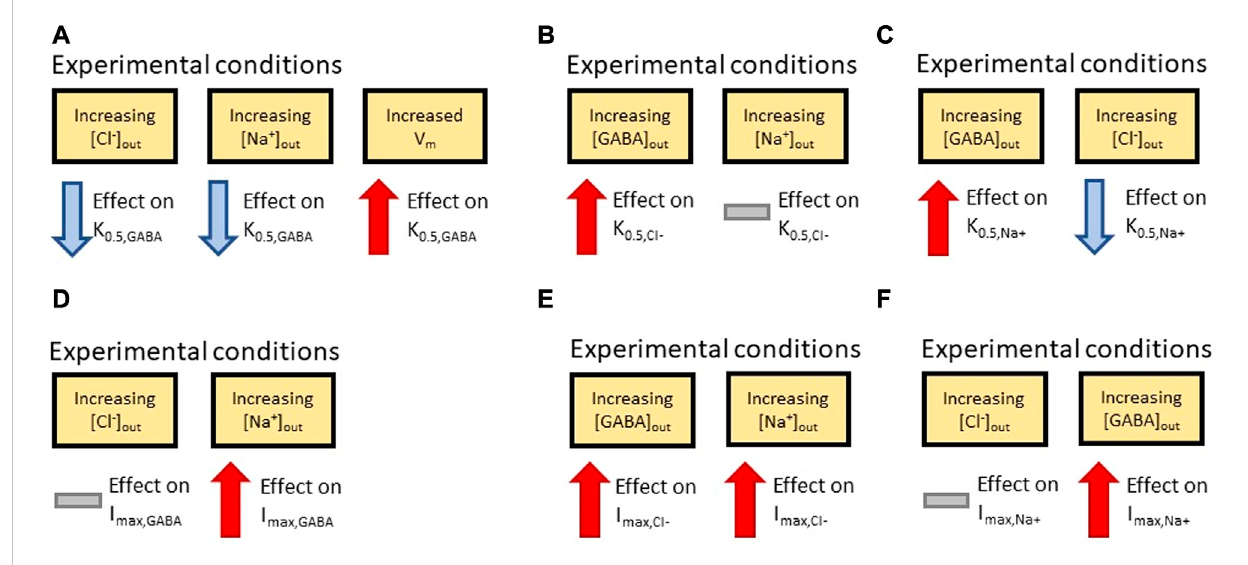
FIGURE 2 Changes in K 0.5 or I max as a consequence of the variation of experimental conditions; Figure is adapted from Loo et al. (2000). From (A – F) : The orange boxes represent changes in the experimental conditions, their effects on the parameter K 0.5 or I max are indicated below. A red upward arrow indicates an increase of the respective parameter, a blue downward arrow indicates a decrease, while a gray rectangle indicates no signi fi cant